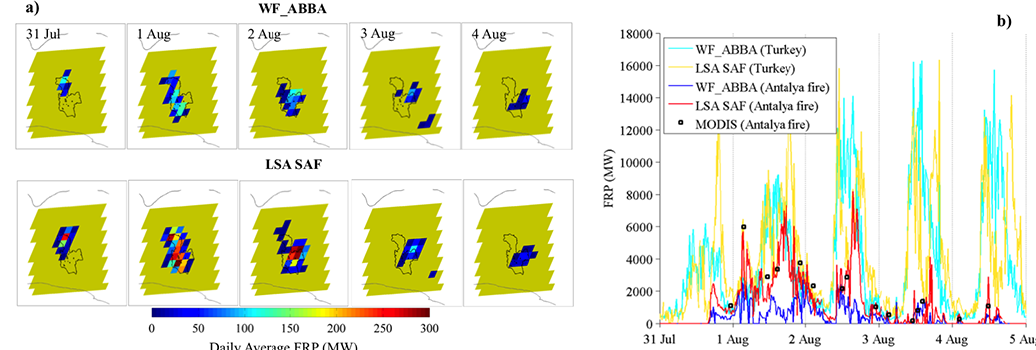
Figure 2. (a) Daily average FRP (MW) over the Antalya fire. (b) Total fire radiative power (FRP) detected over the eastern Mediterranean and over the Antalya fire between 30 July 2008 and 6 August 2008. The data are derived from the WF_ABBA and LSA SAF. Open black squares indicate the FRP observed over the area of the Antalya fire at a lower temporal resolution by the two MODIS